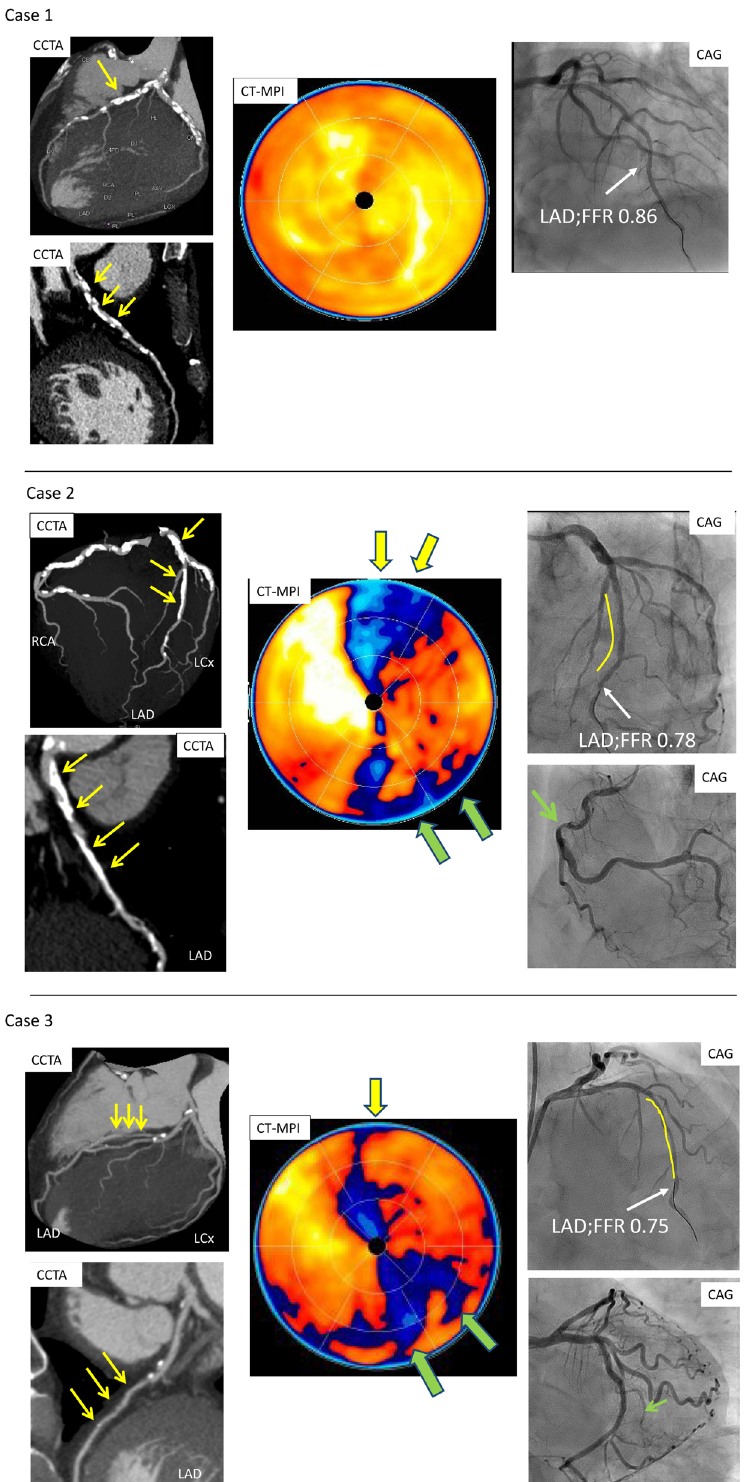
Fig 2. Case examples of CCTA, CT-MPI without stress, coronary angiography, and invasive FFR. Case 1. CCTA showed significant coronary artery calcification in the proximal LAD (yellow arrow). CT-MPI without stress showed no perfusion defect. Coronary angiography confirmed no significant stenosis in the LAD